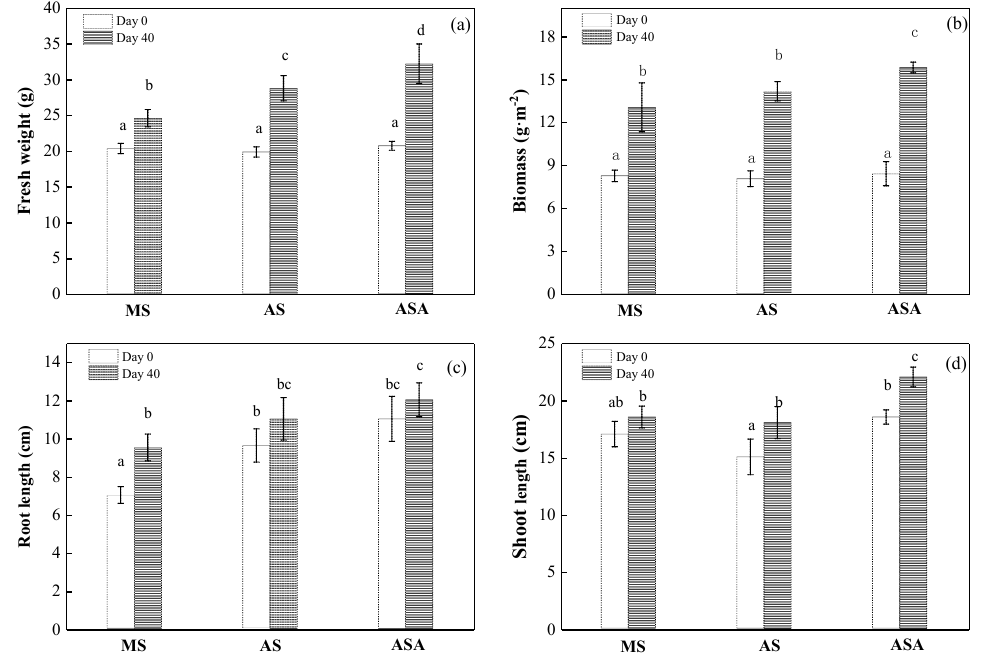
Figure 3. E ff ects of the di ff erent revegetation methods on the growth of V. Figure 3. Effects of the different revegetation methods on the growth of V. natans.